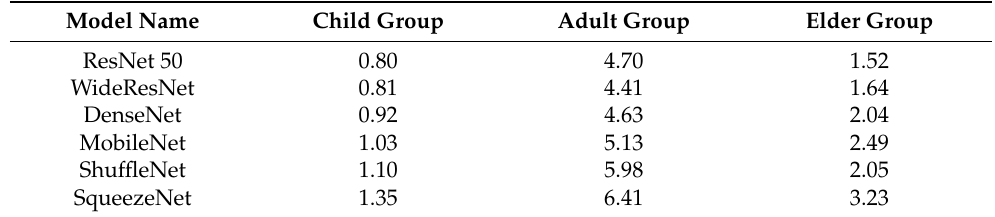
Table 3. Age-group-wise mean absolute error comparison of the experimented convolutional neural networks regarding real age estimation over synthetic masked IMDB-WIK dataset.